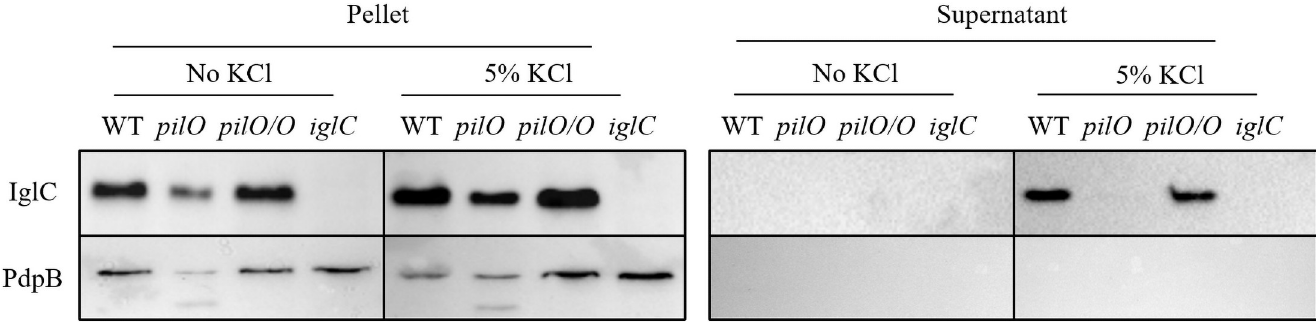
Fig 5. Secretion of the T6SS effector proteins. The presence of the IglC was followed in the concentrated supernatants or in bacterial pellets of wt F . novicida , the pilO mutant and the complemented strain pilO/O grown in the presence or absence of 5% KCl. As control, a secretion defective mutant, the iglC , was used as well as the inner membrane protein the PdpB. Figure shows one experiment representative of three independent experiments.